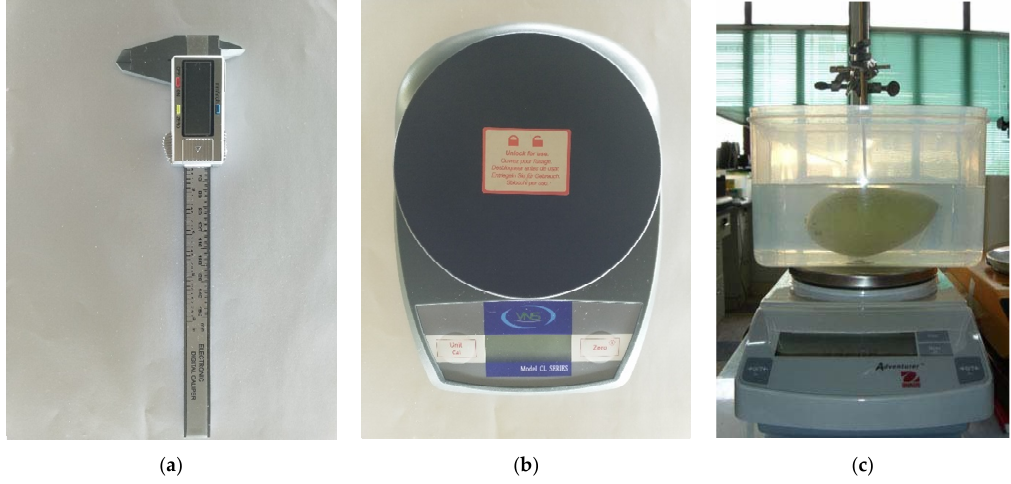
Figure 3. Measurement tools: ( a ) digital caliper, ( b ) digital scale, and ( c ) water displacement method Figure3. Measurementtools: ( a )digitalcaliper, ( b )digitalscale, and( c [39].